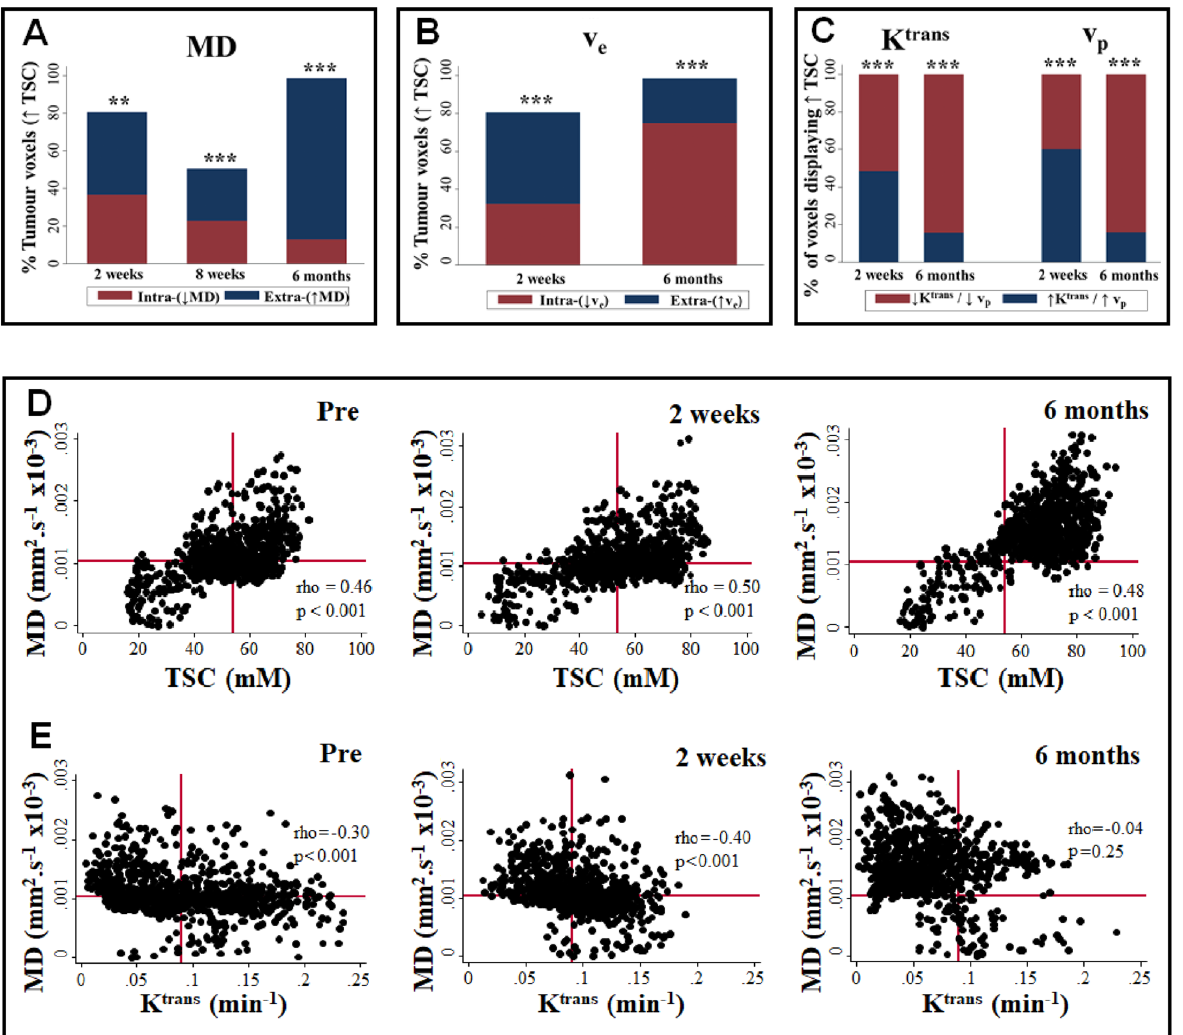
Figure 3. Temporal changes in extracellular and intracellular total sodium population and DCE-MRI derived microvascular parameters. ( A ) Bar-chart showing percentage of all tumour voxels demonstrating increased TSC and an increase ( ↑ TSC: ↑ MD) or decrease in MD ( ↑ TSC: ↓ MD) at 2 weeks, 8 weeks, and 6 months post-treatment. Note the increase in the percentage of tumour voxels displaying ↑ TSC: ↑ MD at 6 months post-treatment. ( B ) Bar-chart showing percentage of all tumour voxels demonstrating increased TSC and an increase ( ↑ TSC: ↑ v e ) or decrease in v e ( ↑ TSC: ↓ v e ) at 2 weeks and 6 months post-treatment. Note the increase in the percentage of tumour voxels displaying ↑ TSC but ↓ v e at 6 months post-treatment. P value shown is for comparison of all tumour voxels displaying an increase in either the extracellular ( ↑ TSC: ↑ MD or ↑ TSC: ↑ v e ) or intracellular ( ↑ TSC: ↓ MD or ↑ TSC: ↓ v e ) sodium population (one-sample test of proportions ** P < 0.01 *** P < 0.001). ( C ) Bar-chart showing percentage of tumour voxels with increased TSC ( ↑ TSC) that display an increase ( ↑ ) or decrease ( ↓ ) in K trans and v p at 2 weeks and 6 months post-treatment. Note the increase in the percentage of tumour voxels displaying ↓ K trans and ↓ v p at 6 months post-treatment. P value shown is for comparison of all tumour voxels displaying either an increase or decrease in K trans and v p respectively (one- sample test of proportions ** P < 0.01 *** P < 0.001). ( D ) Voxelwise scatterplot comparison of tumour TSC values and mean diffusivity (MD) estimates shown for patient 5 at different timepoints. Horizontal and vertical red bar indicates the 50% percentile for the pre-treatment voxelwise MD and TSC estimates respectively. ( E ) Voxelwise scatterplot comparison of tumour mean diffusivity (MD) values and K trans estimates shown for patient 5 at different timepoints. Horizontal and vertical red bar indicates the 50% percentile for the pre-treatment voxelwise MD and K trans estimates respectively. Note the increase in the percentage of tumour voxels displaying ↑ TSC and ↑ MD but ↓ K trans at 6 months post-treatment. Spearman’s rho reported on